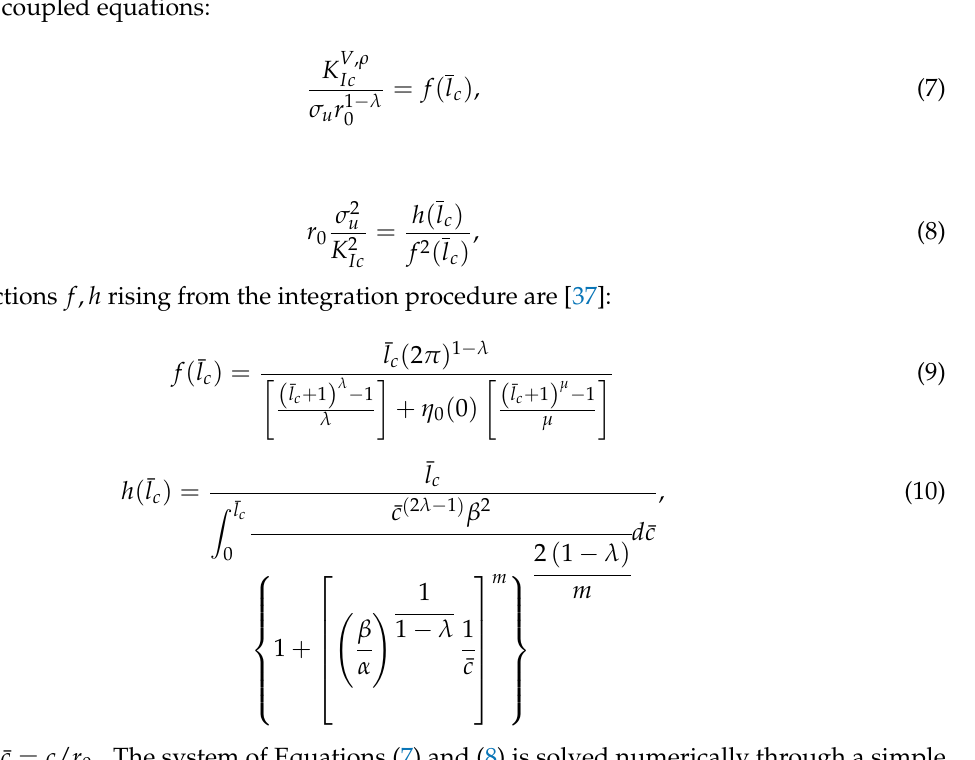
(cid:13) MATLAB R code: For a given structure, after extracting l c from Equation (8), the apparent